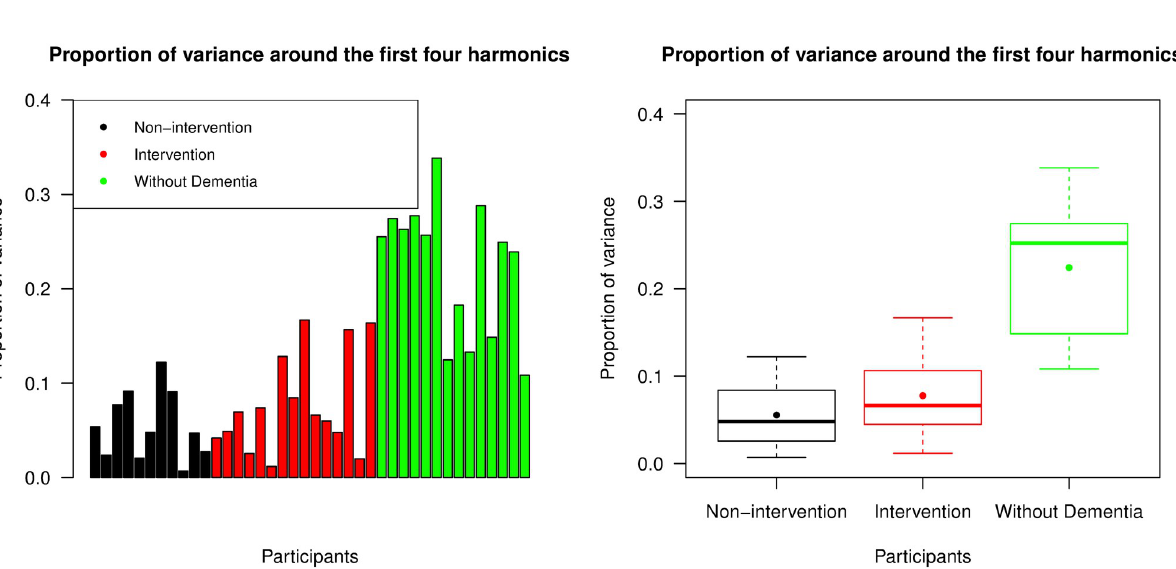
Fig 11. Proportion of variance around the first four harmonics (PoV ( H ) ). The left panel displays PoV values explained by the periodogram around the first four harmonic frequencies across all participants, with the same ordering of individuals as the bar chart representing IS values; the right panel is a box plot collating these PoV values across the non-intervention group, the intervention group, and the group of individuals without dementia. For each group, the median and mean of the PoV ( H ) values are presented by a thick line and a point in its own box, respectively.